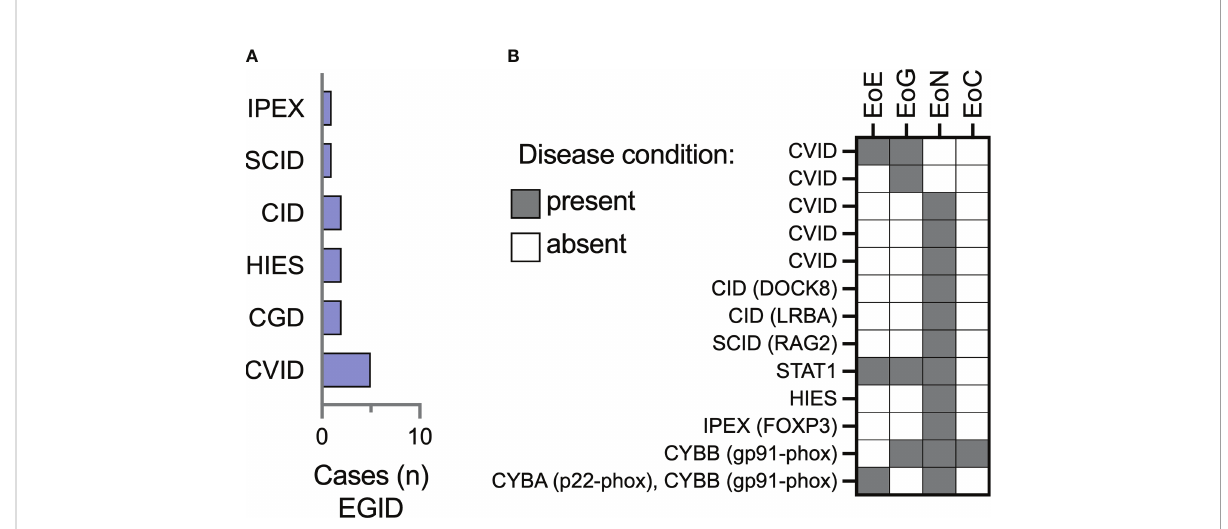
FIGURE 2 Eosinophilic enteritis is the most frequently represented site of extraesophageal GI eosinophilia among IEI patients in the USIDNET cohort. (A) The number of patients (n = 13 total) with a site of extraesophageal EGID are represented using the immunode fi ciency category assigned within the USIDNET at the time of data collection. (B) Representation of the location of gastrointestinal eosinophilia on a per-patient basis. CVID, Common variable immunode fi ciency; CGD, chronic granulomatous disease; HIES, Hyper-IgE syndrome; SCID, severe combined